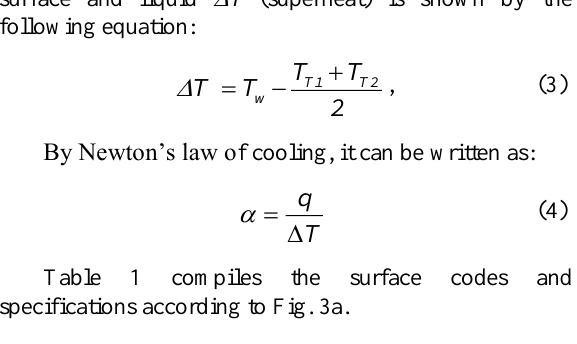
Table 1. MC surface codes and specifications.